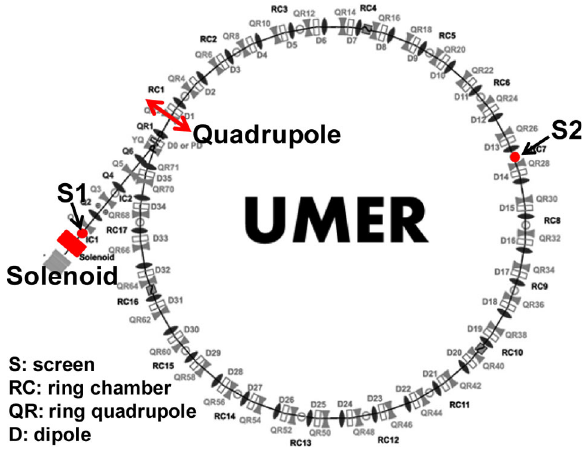
FIG. 10. Schematic layout of